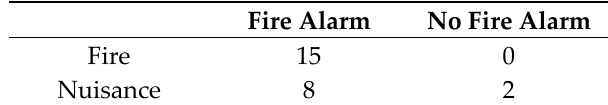
Table 1. Confusion matrix of the model when it is trained with data from standard fire room only. Although the system is able to detect all the fires, the number of false positive is unacceptable.